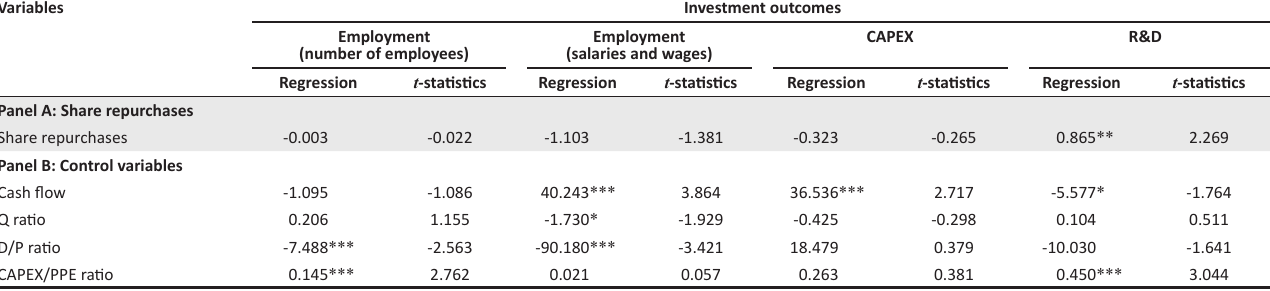
TABLE 2: Panel regression results, measuring the relationship between investment outcomes and share repurchases.